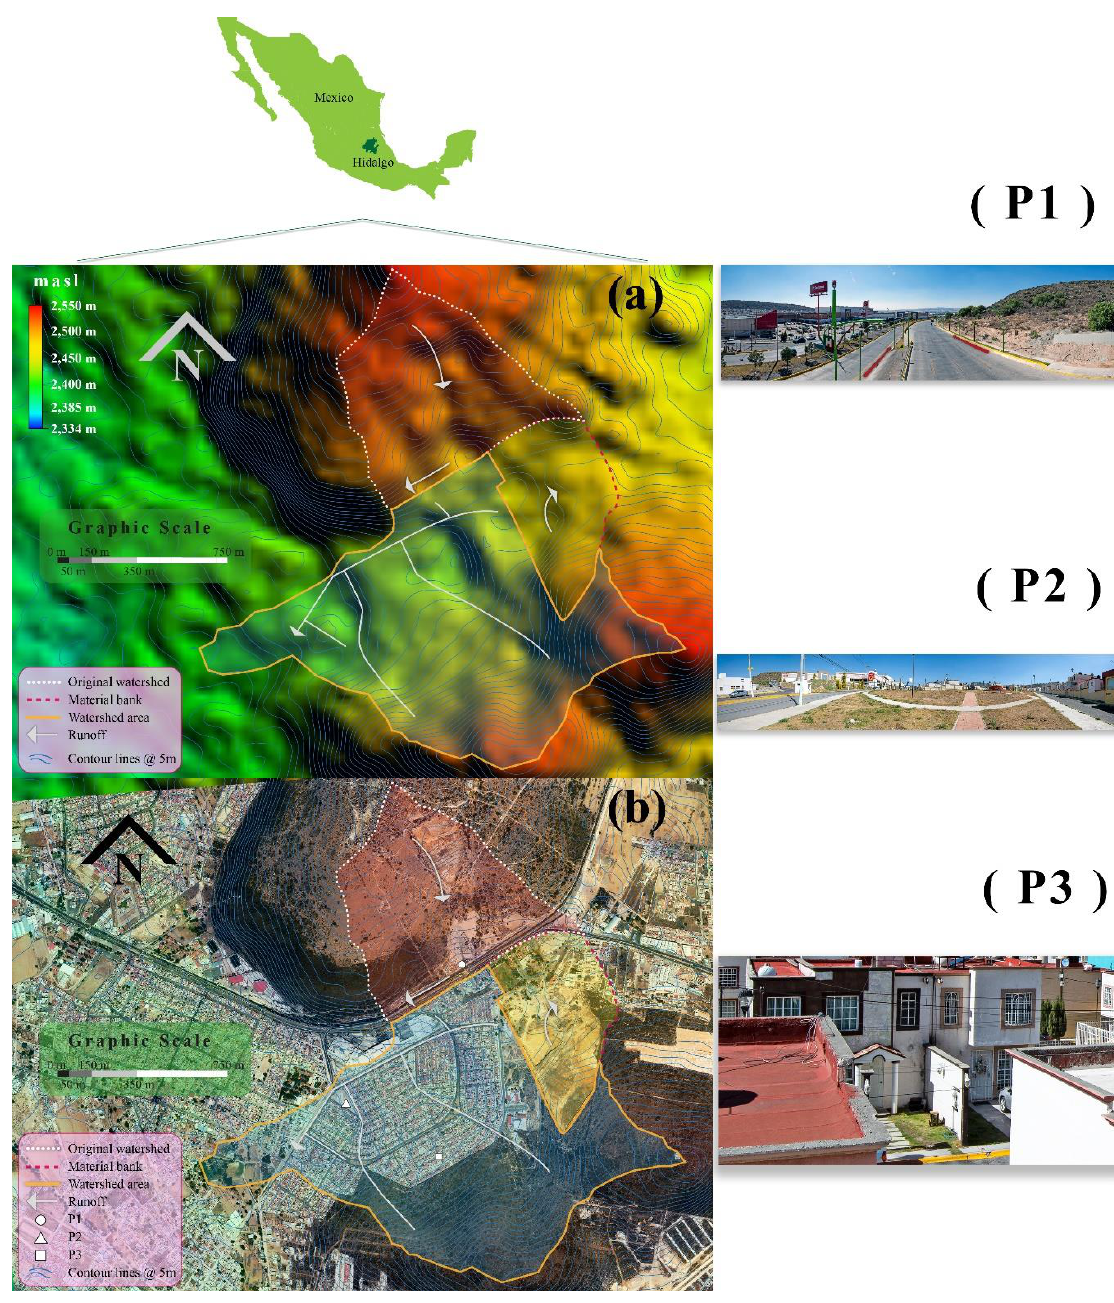
Figure 1. Location of the study area: ( a ) unaltered natural watershed, and ( b ) definition of soil use at the current urban watershed. P1 shows the deviation of runoff from the north of the watershed; P2 corresponds to one of the common green spaces; P3 shows a typical house with its garden area.